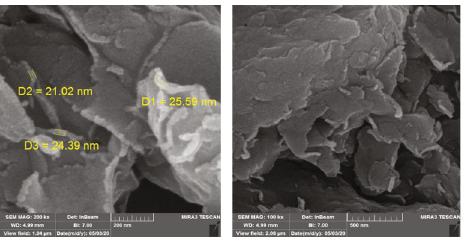
Figure 15: FESEM image of prepared nanoclay